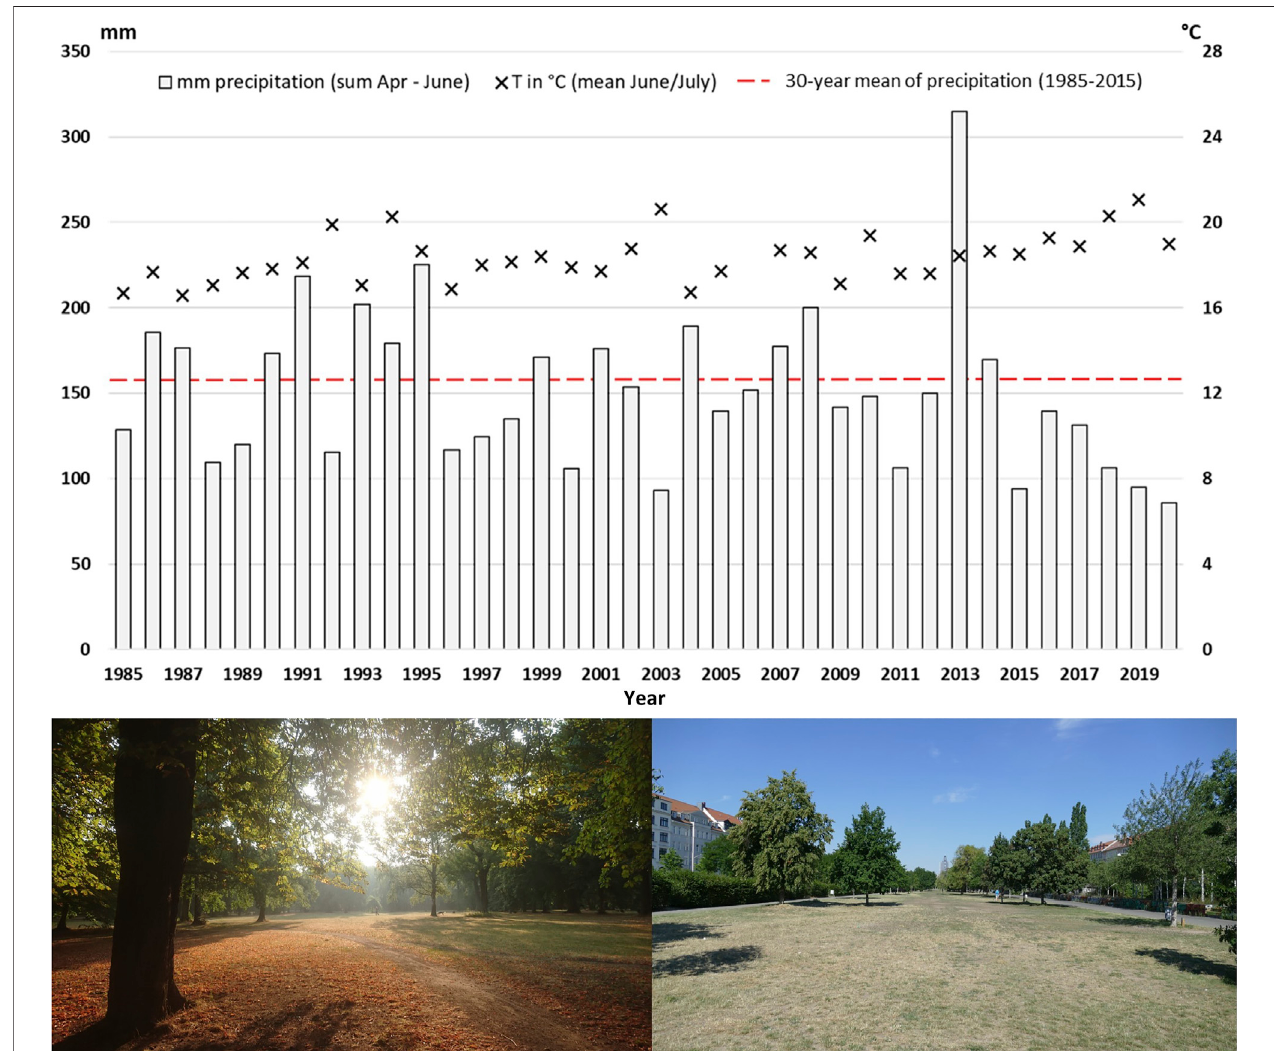
FIGURE 1 | Climate data for Leipzig (retrieved from Deutscher Wetterdienst, Climate Data Center (CDC), 2021, station 2928 “ Leipzig-Holzhausen ” ) and impressions from summer 2018 and 2019. Bottom left: early foliage shedding of trees due to drought and heat stress (Photo taken on 23 July 2018 by the authors). Bottom right: degradation of grass cover due to repeated, perennial drought (Photo taken on 6 July 2019, extracted from Kabisch et al.,